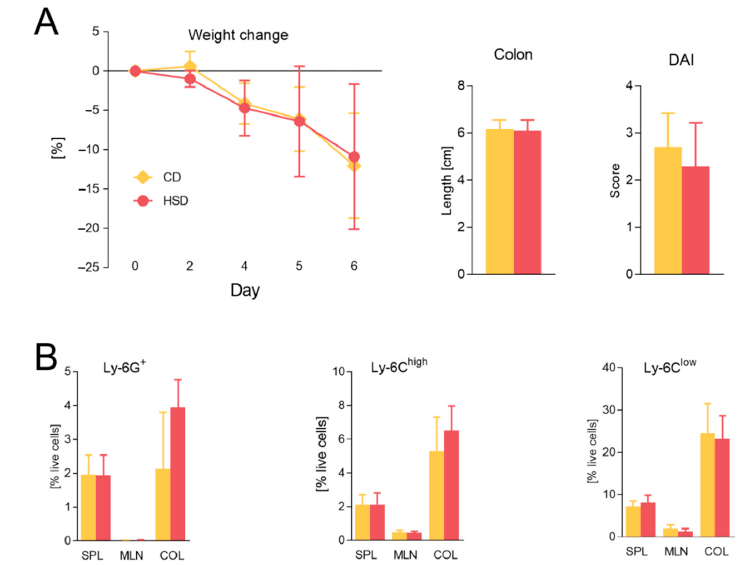
Figure 8. Harmful effect of HSD in acute colitis is not transferred by microbiota alone. ( A ) Weight change, colon length, and DAI are shown. ( B ) Percentage of live cells from spleens, mesenteric lymph nodes, and colons measured by flow cytometry. Data presented are from two experiments, n = 5–8 mice per group. The weight loss was analyzed by two-way ANOVA with Bonferroni post hoc test and other parameters by unpaired t test in a respective organ. Data are shown as mean ± SD. CD, control diet; HSD, diet rich in simple carbohydrates; SPL, spleen; MLN, mesenteric lymph nodes; COL,